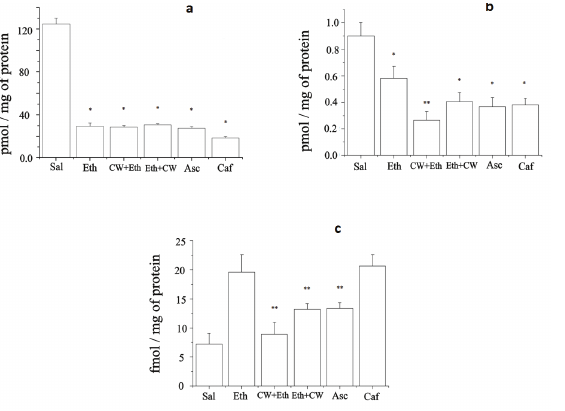
Figure 6 - Effect of CW, ascorbic and caffeic acid in GSH percentage in plasma of rats treated by ethanol. The results are express in percentage in relation to Saline group. Eth – 2.5 mL/Kg of solution 35%; CW+Eth – 3 mL/Kg of coconut water followed by 2.5 mL/Kg ethanol; Eth+CW – 2.5 mL/Kg of ethanol followed by 3 mL/Kg of coconut water; Asc + Eth – 3 mL/Kg of solution 25 µg/µL followed by 2.5 mL/Kg of ethanol; Caf + Eth – 3 mL/Kg of solution 100 µg/µL followed by 2.5 mL/Kg of ethanol. The data are average ± S.D for five animals. Means values were significant different for p<0.05; (*) different when compared with saline group p<0.05; (**) different when compared with ethanol group p<0.05. For multiple comparisons, ANOVA, followed by Dunnett’s test, were